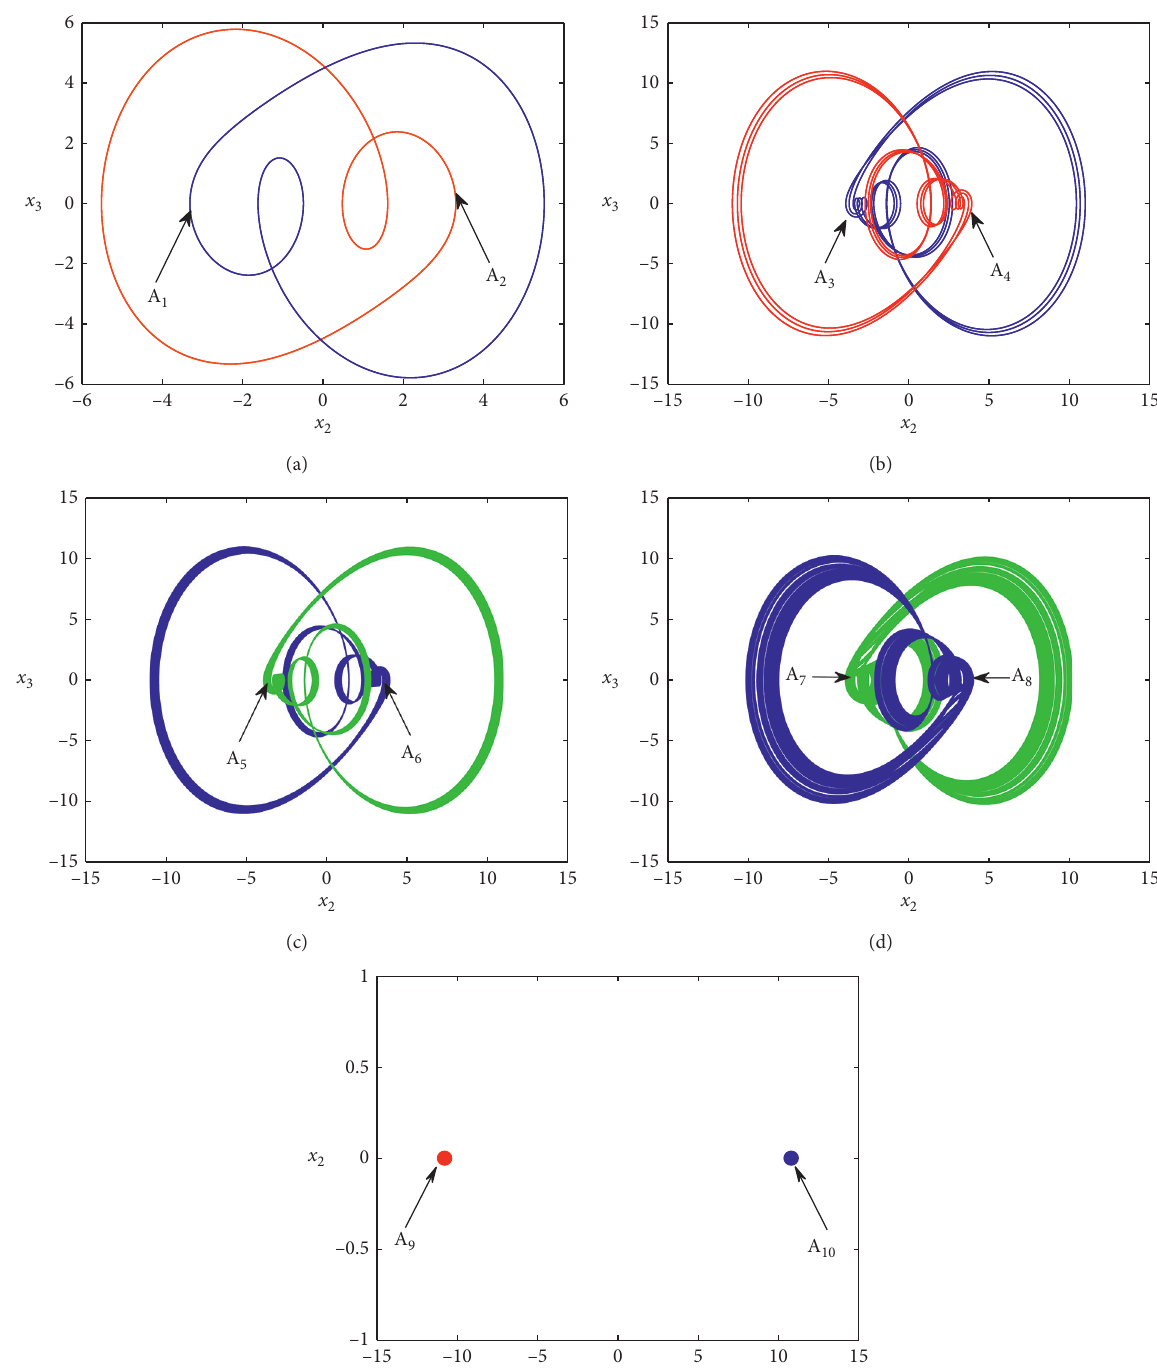
Figure 18: Coexistence of ten different attractors (a pair of symmetric period-2 limit cycle, 2 pair of symmetric chaotic attractors, a pair of symmetric period-9 limit cycle, and a pair of point attractors). The parameters are the same as those in Figure 16. Initial conditions are given in Table